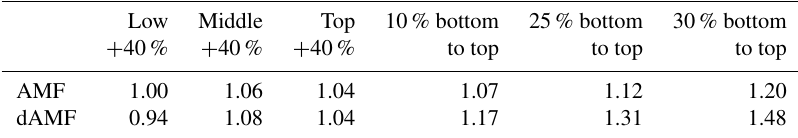
Table A31. Ratios of (d)AMFs for 8 July 2013 for the modified profiles with respect to the original profile. Low Middle Top 10% bottom 25% bottom 30% bottom + 40% + 40% + 40% to top to top to top AMF 1.00 1.06 1.04 1.07 1.12 1.20 dAMF